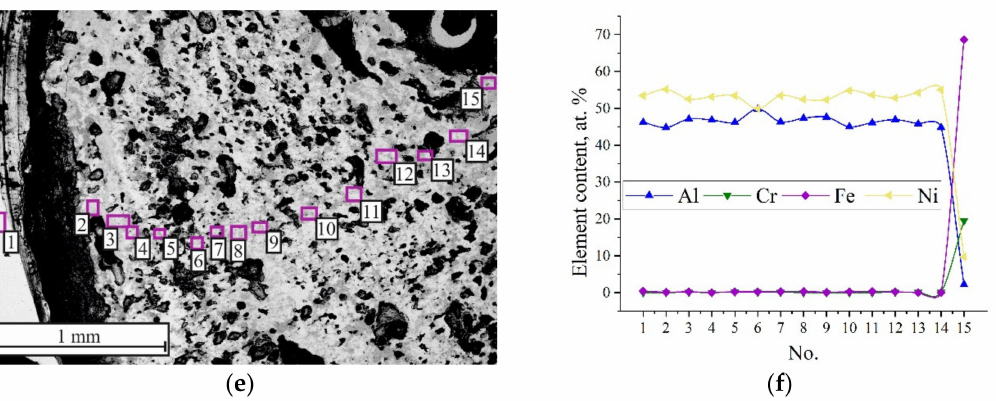
Figure 8. SEM images of segment II microstructure and EDS analysis results: ( a ) upper part in ampoule No. 1; ( c ) lower part in ampoule No. 1; ( e ) lower part in ampoule No. 2; ( b , d , f ) element distribution after EDS analysis.